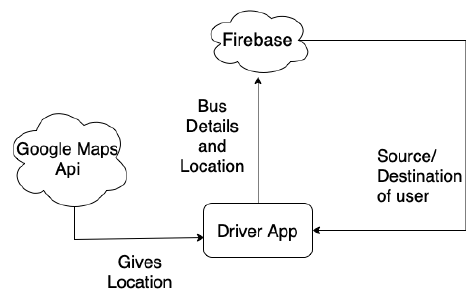
Figure 2: Functional Block Diagram of Driver Unit